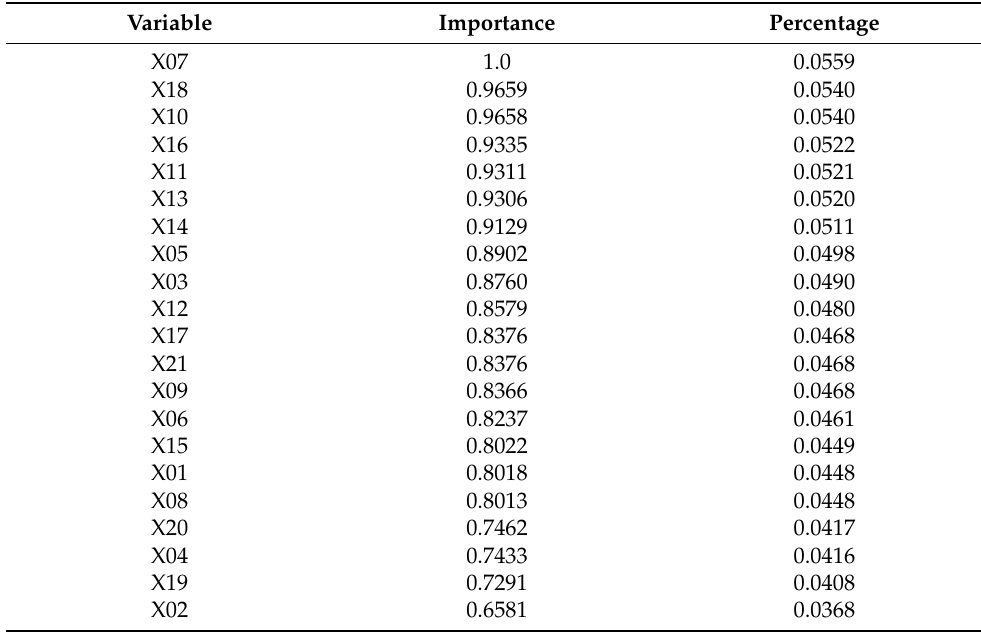
Figure 4. The generated model for women and the learning process. Table 4. Parameters of the generated model—age assessment for women.